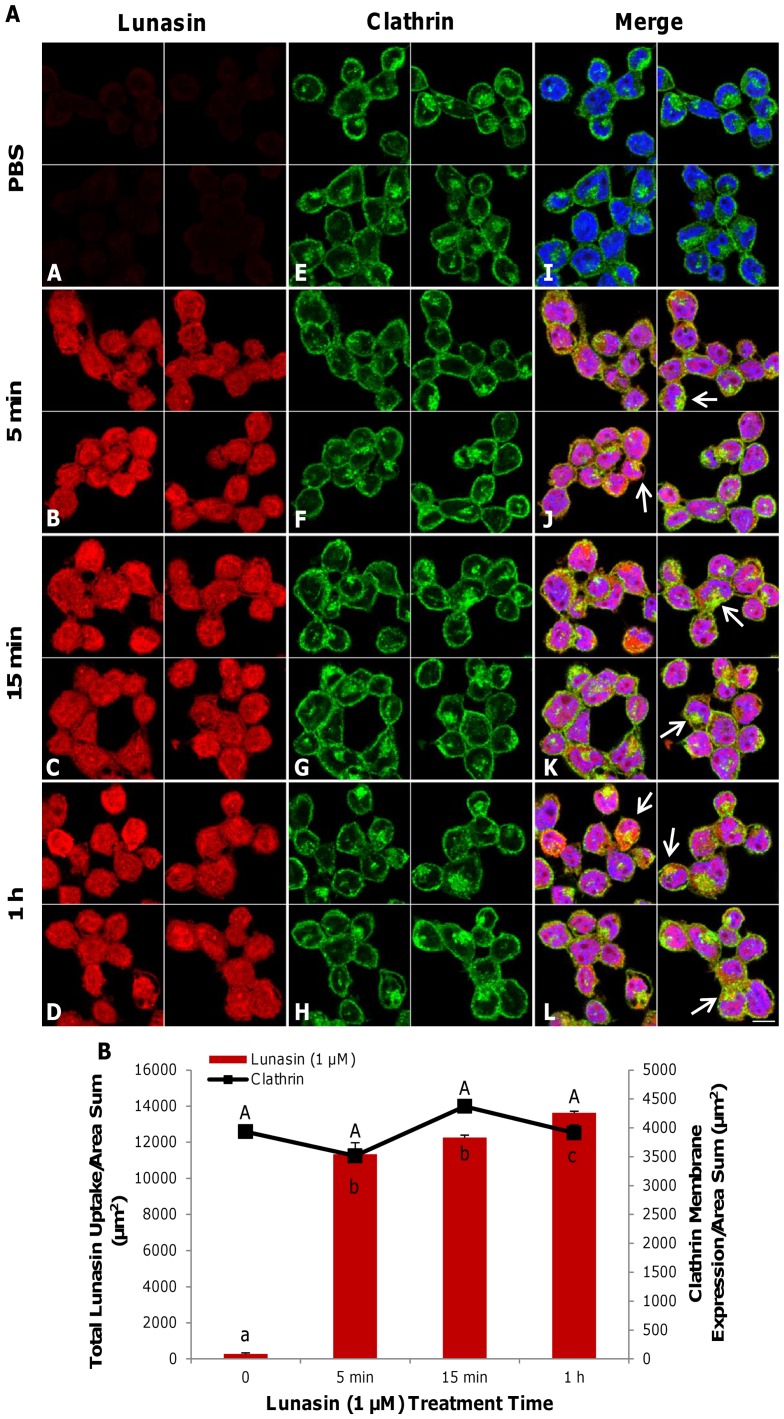
Lunasin accumulated within intracellular clathrin-coated structures.Two-dimensional optical planes showing the immunofluorescent localization of lunasin (red), clathrin (green) and nuclei (blue) (
Figure 2A
). Total lunasin uptake by macrophages increased over time (A–D), while clathrin expression at the membrane surface was unchanged by the treatment (E–H). Immunofluorescence and the merged image of lunasin, clathrin and nuclei are shown (I–L). Lunasin localized to specific regions with high clathrin expression (J–L, arrows). Quantification of total lunasin uptake and clathrin membrane expression over the time-course of lunasin treatment (
Figure 2B
). Four independent fields of view from three independent replicates of cells were merged together per treatment group. In Figure 2B, the data represent the average of triplicates or quadruplicates ± SE. Means with different letters are significantly different from each other (n = 3, p<0.05). Bar  = 10 µm.